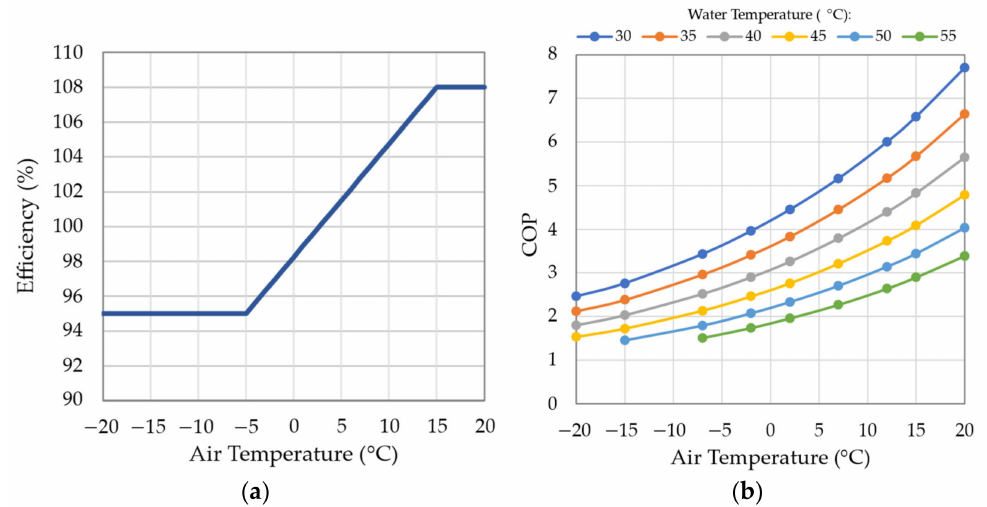
Figure 4. Outdoor temperature dependency of thermal devices: ( a ) condensing gas-fired boiler efficiency; ( b ) coefficient of performance of an air-to-water electric heat pump.